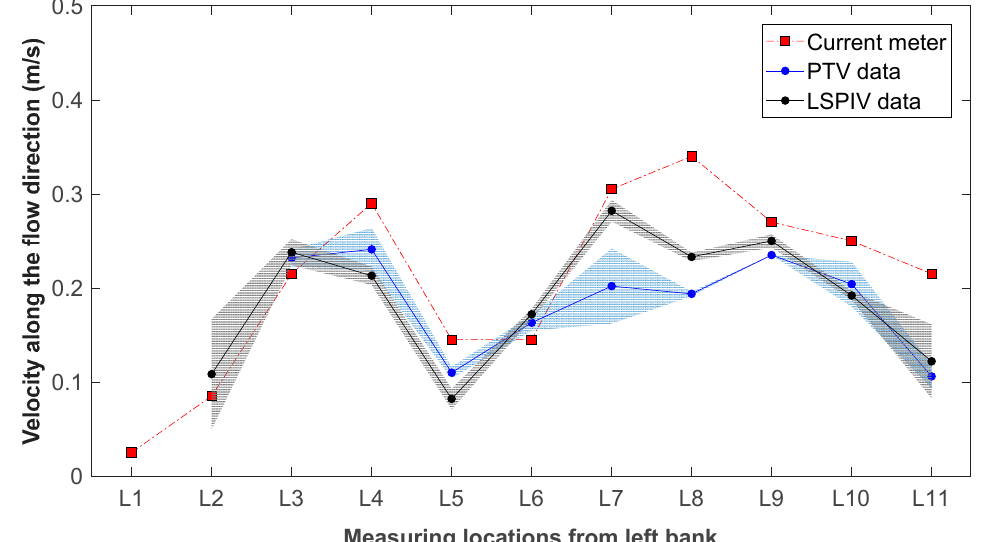
Figure 11. Comparison between surface velocity estimations computed with PTV and LSPIV for experiments conducted on frame windows in the Basento River. Shaded regions indicate standard deviations between frame sequences. Values recorded with the current meter are also reported.